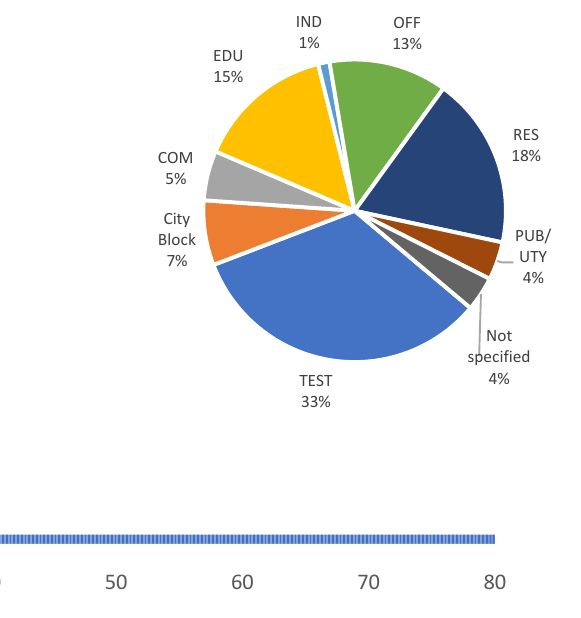
Figure 12. The scale of UGI in relation to the building type.